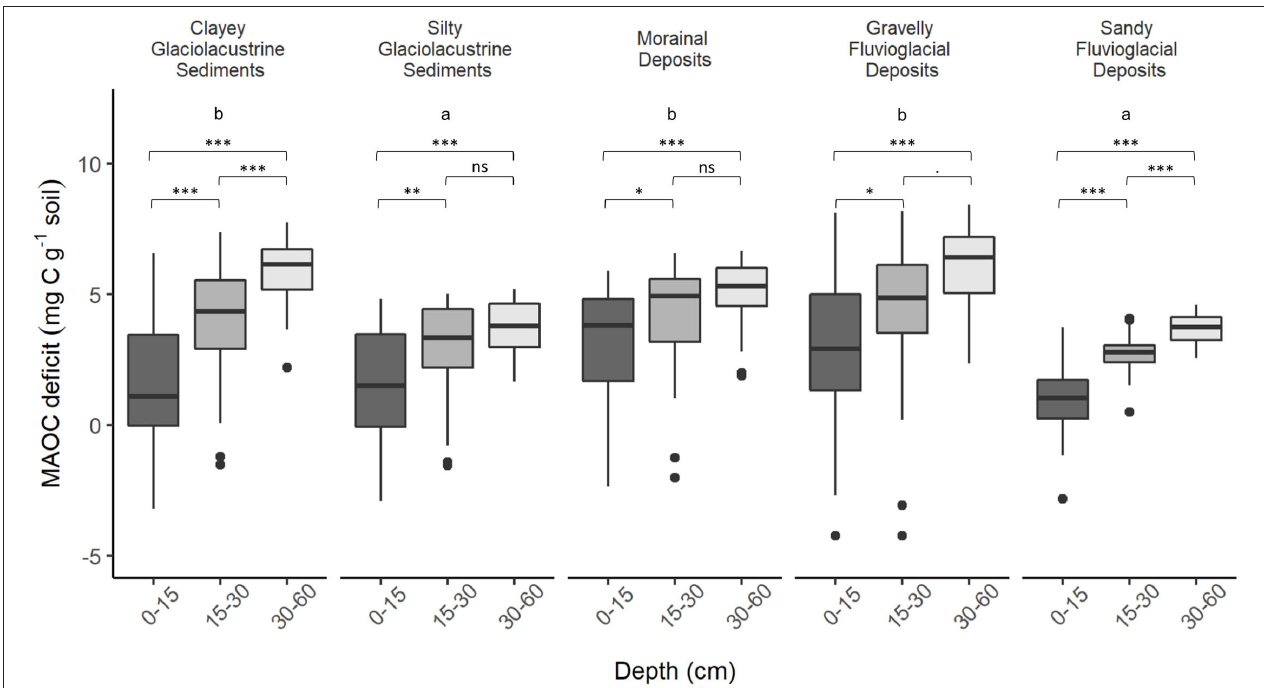
FIGURE 7 | Mineral-associated organic carbon deficits by soil group and depth, calculated as the difference between the MAOC formation capacity estimated using a 90th quantile approach and the current MAOC. Boxes show the 25th to 75th interquartile range, with the median shown as a black bar. Whiskers show the range of data present for each box. Significant differences between samples from different depths within a soil type, determined using ANOVA with means separation using Tukey’s Honestly Significant Difference (Tukey’s HSD) test are shown above each soil depth combination (ns, not significant; .: p ≤ 0.1; * p ≤ 0.05; ** p ≤ 0.01; *** p ≤